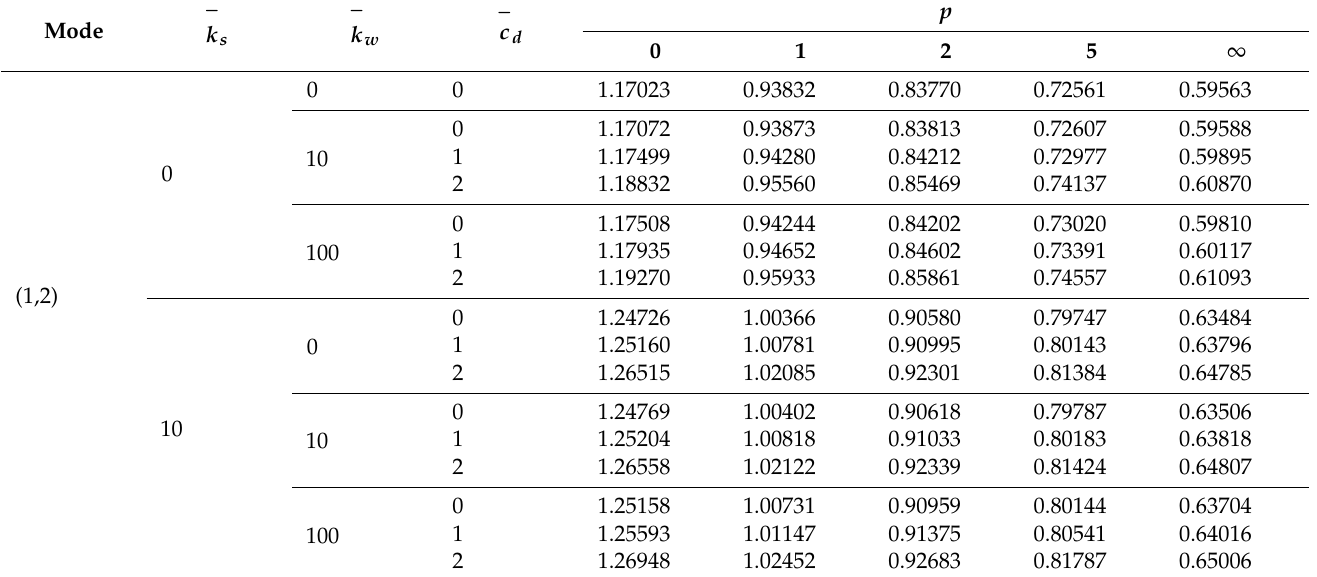
Table 18. Non-dimensional natural frequencies (cid:101) ω = ω h ( h / a = 0.2, b / a =